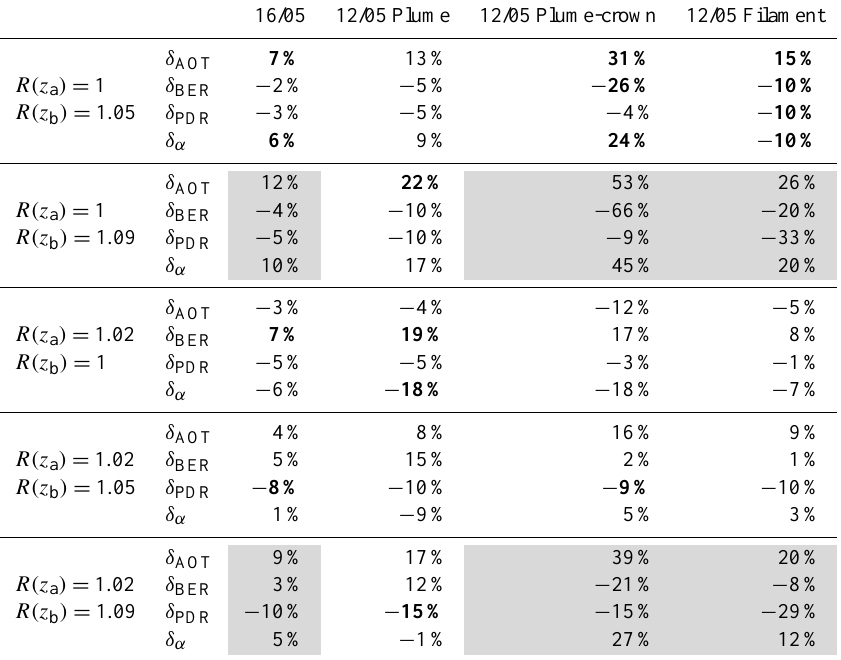
Table 3. Relative bias ( δ x ) linked to the presence of aerosol at the two altitudes of normalization z a and z b . When aerosols are present, the scattering ratio R is higher than 1. The gray areas are for assessments with R(z b ) = 1 . 09, which are not took into account in the error budget. The values in bold are those considered in the global error budget.